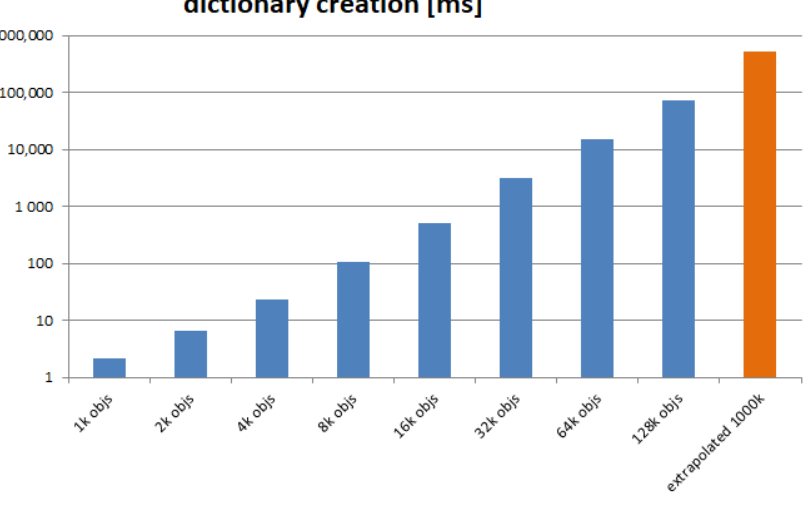
Figure 11. Object Dictionary creation time, logarithmic